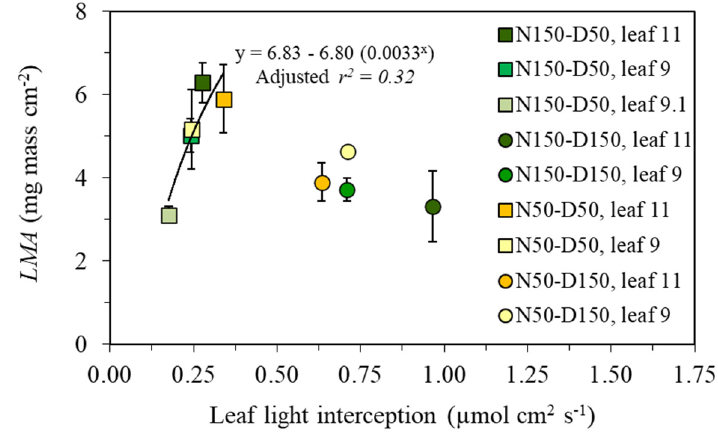
Figure 6. Relationship between leaf mass per unit of area ( LMA ) and light interception by leaves located in a given layer at 7 days before flowering (BBCH 62). Vertical bars indicate the standard error of means.